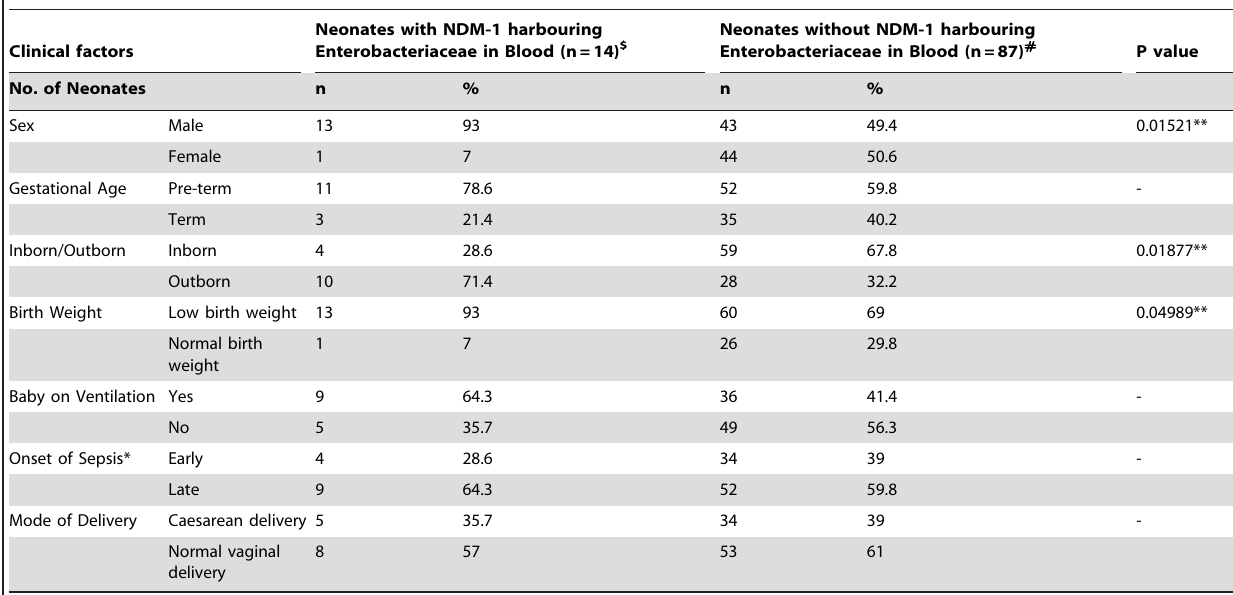
Table 6. Association of clinical factors with sepsis caused by NDM-1 harbouring Enterobacteriaceae in neonates.